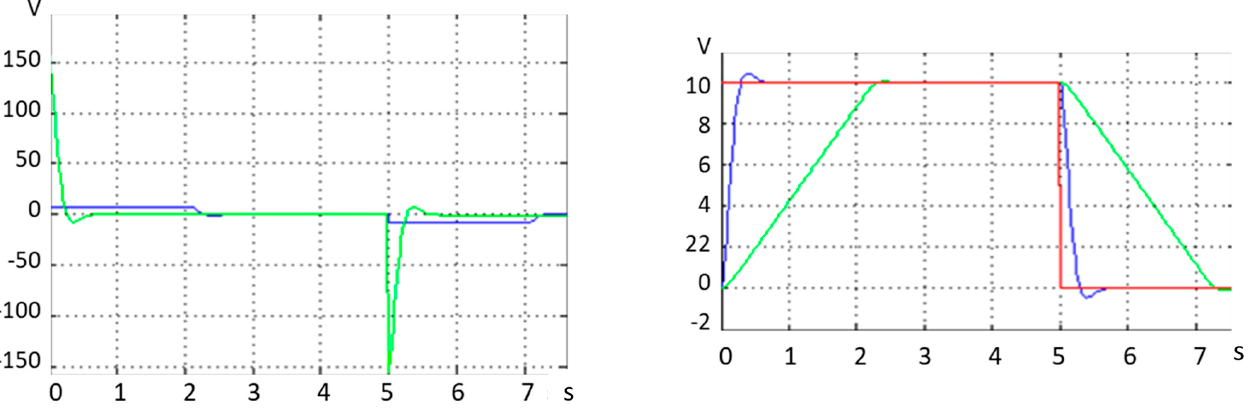
11 of 27 Figure 5. Control system simulation for limit rotations.